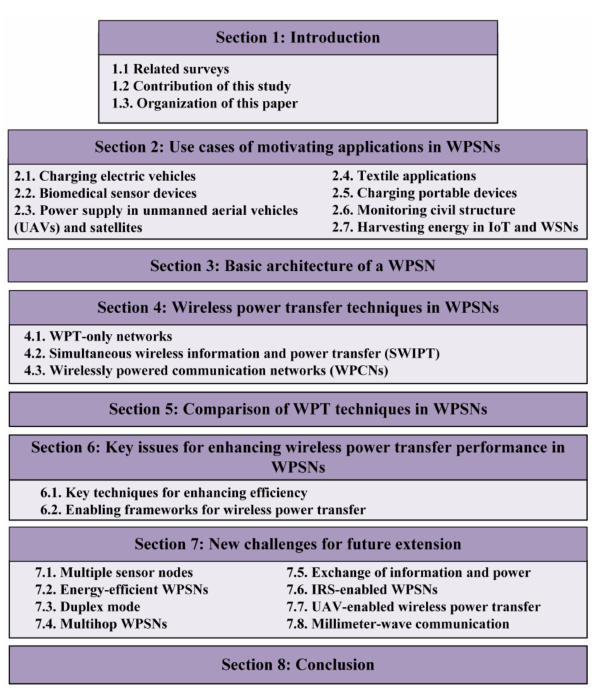
Figure 1. Outline of the